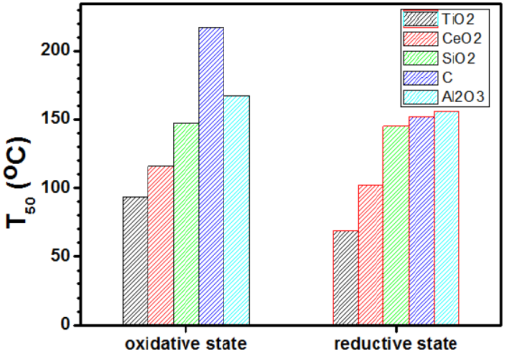
Figure 8. Comparison of T 50 values for Pd 48 Cu 52 catalysts over different supports (i.e., TiO 2 (black), CeO 2 (green), SiO 2 (red), carbon (blue) and Al 2 O 3 (cyan)) initially treated at 260 ˝ C under N 2 and then under reductive under 15 vol % H 2 at 400 ˝ C followed by further treatment either under O 2 at 450 ˝ C for 30 min, denoted on the plot as oxidized state, or under H 2 at 300 ˝ C for 30 min, denoted on the plot as reduced